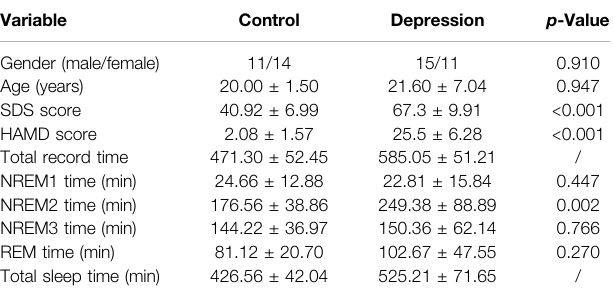
TABLE 1 | Demographic features and polysomnographic parameters of the depressed group and controls.